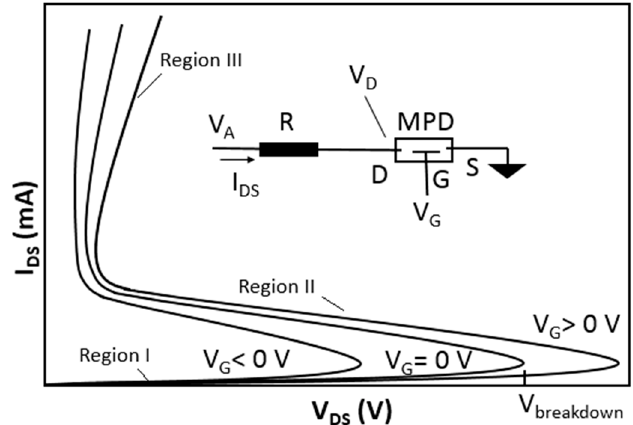
Figure 1. Schematic of current versus voltage I–V characteristics of a three-terminal microplasma device.